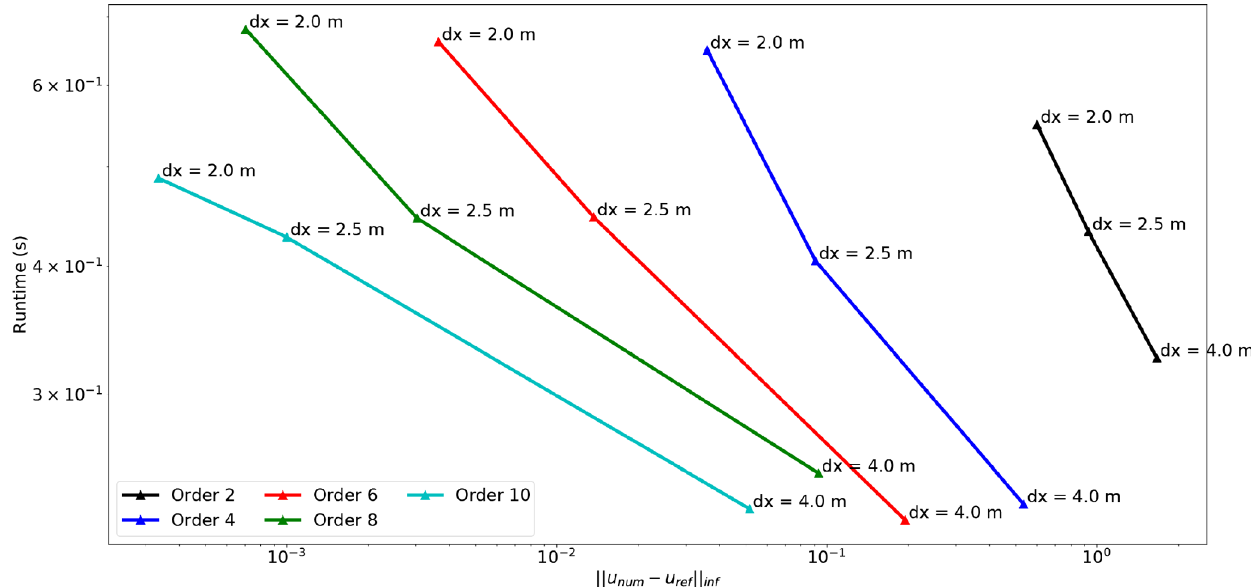
Figure 21. Different spatial discretization order accuracies against runtime for a fixed physical setup (model size in m and propagation time).